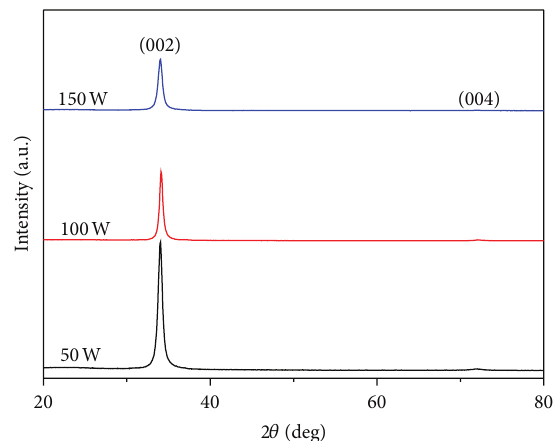
Figure 1: XRD patterns of the GZO thin films as a function of depo- sition